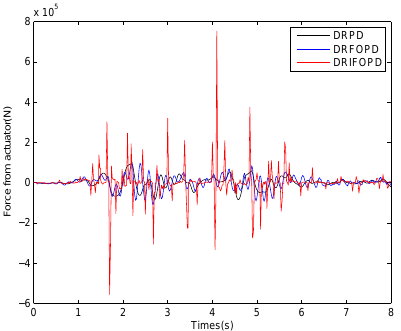
Figure 10. Forces output generated by the actuators under the action of the DRPD, DRFOPD, and DRIFOPD